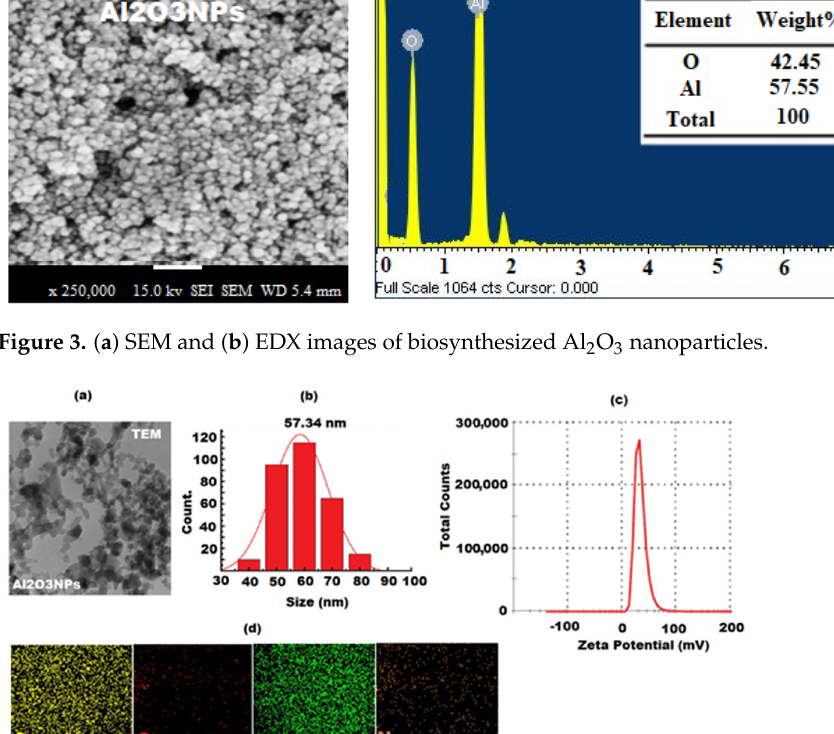
Figure 4. ( a ) TEM, ( b ) particle size distribution, ( c ) DSL analysis, and ( d ) Elemental distribution of oxygen (O), aluminum (Al), carbon (C), and sodium in the EDX mapping of Al 2 O 3